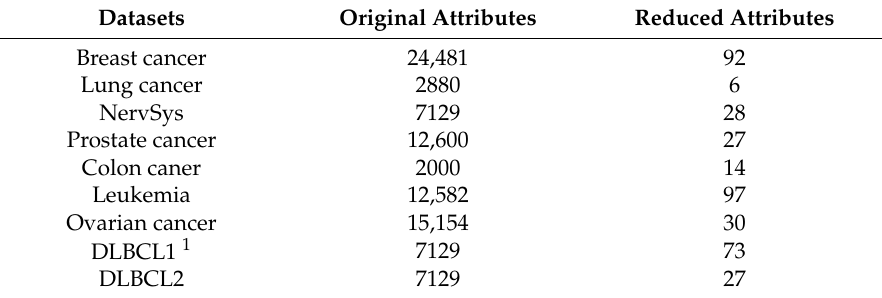
Table 1. Reduced attributes by FCBF.